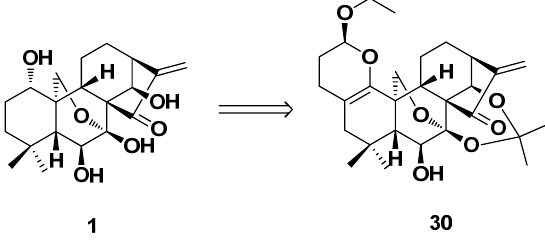
Figure 14. The dihydropyran-fused oridonin 30 .